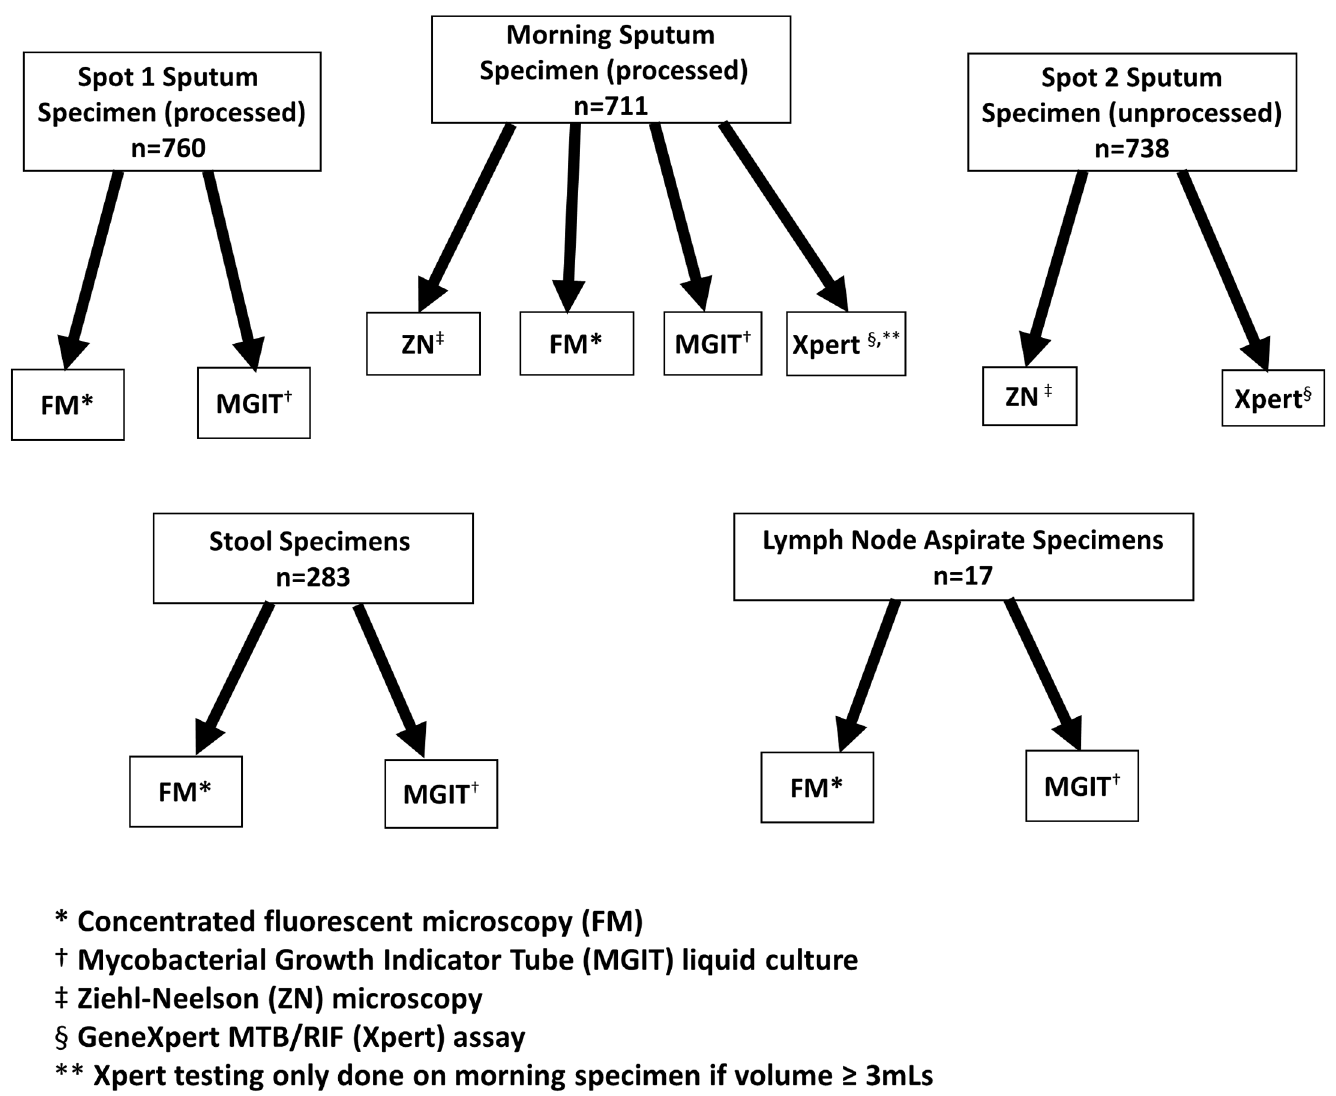
Fig 1. Laboratory tests performed on different